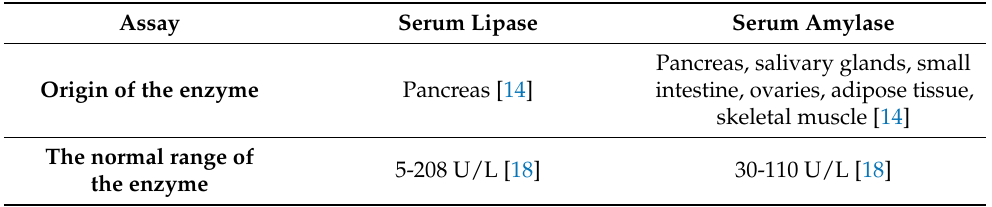
Table 2. Crucial information concerning indicator enzymes used in the diagnosis of acute pancreatitis, based on information published in the studies of Rompianesi et al., Matull et al., and Chase et al., as well as in other